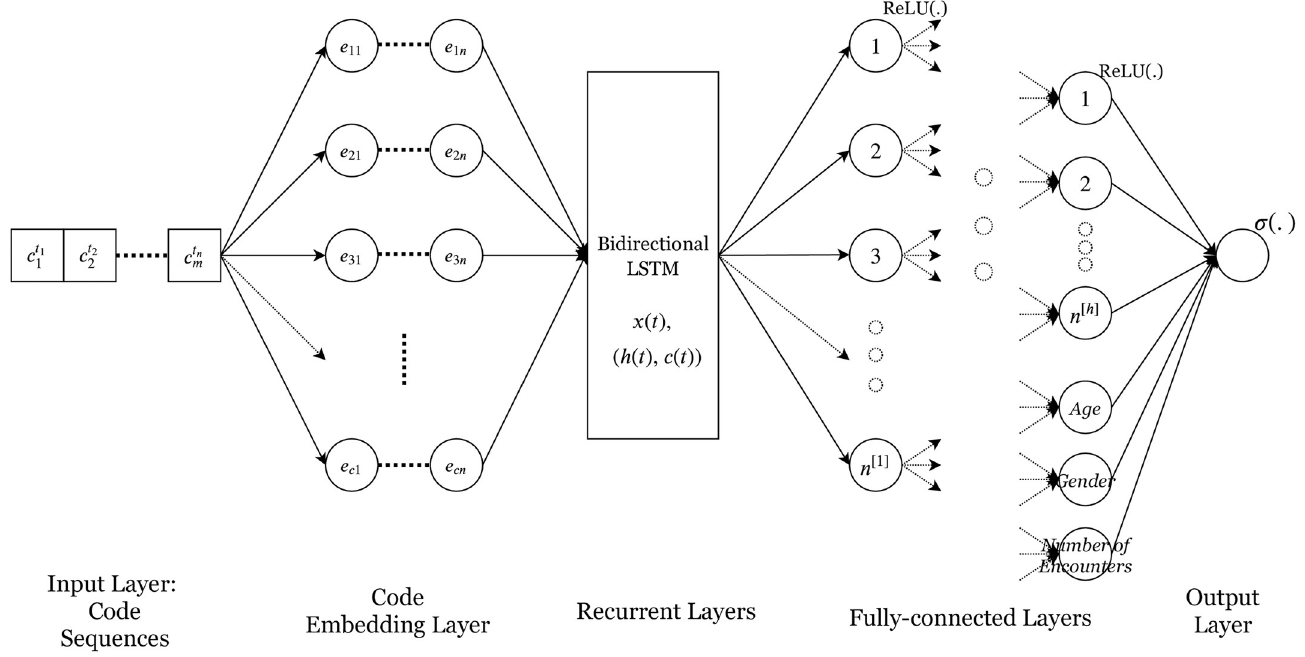
Fig 2. Recurrent neural network